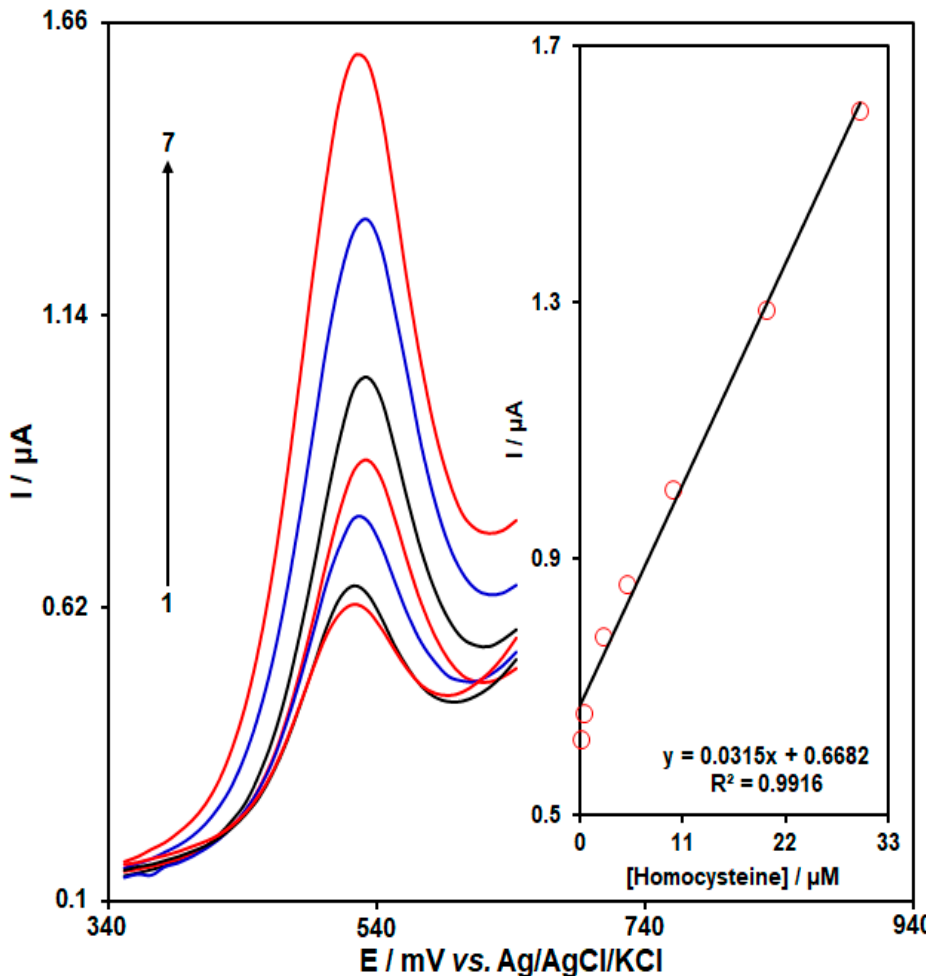
Figure 6. DPVs captured at the aptasensor for homocysteine at variable concentrations in PBS (0.1 M, pH = 7.0). No. 1–7: 0.1, 0.5, 2.5, 5.0, 10.0, 20.0, and 30.0 μ M of homocysteine. Inset: standard curve for homocysteine, plot of peak current versus homocysteine concentration.